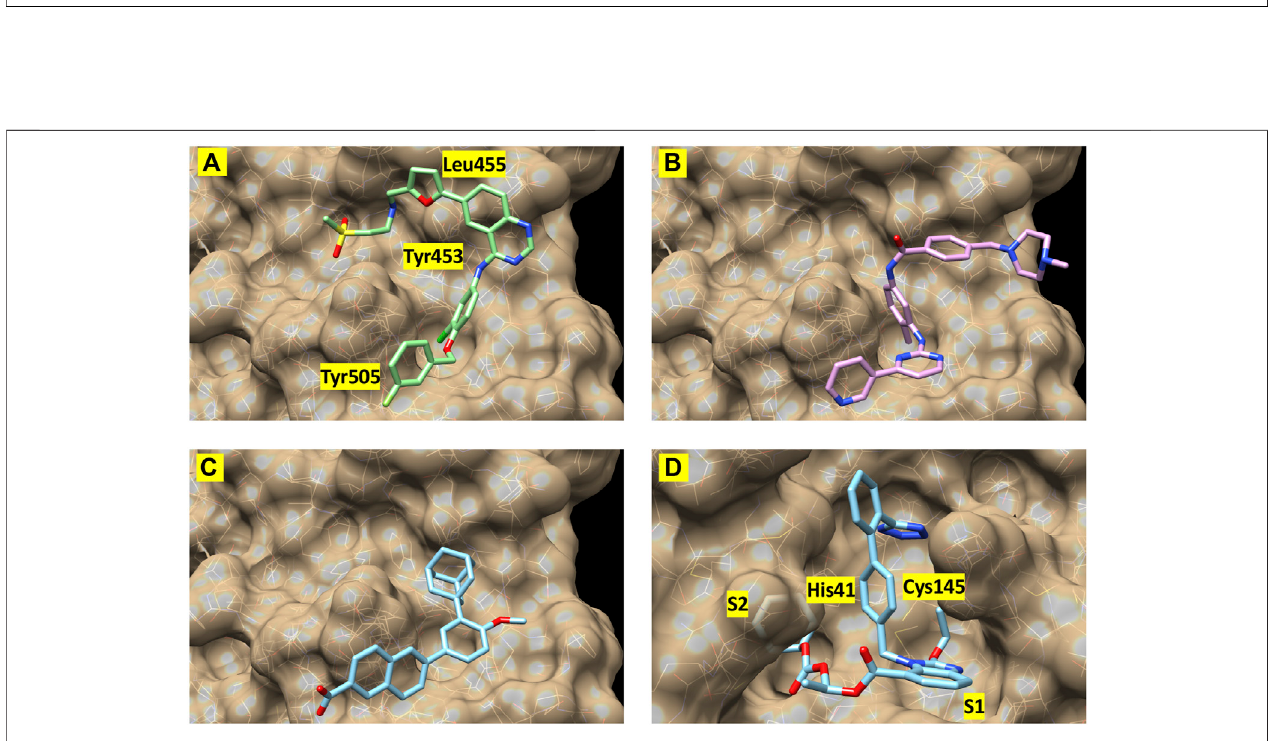
FIGURE7| Best-scoringposefromdockingfor (A) lapatinib, (B) imatinib,and (C) adapalenetothereceptorbindingdomainofthespikeprotein(spike1site).Panel (D) shows the best-scoring dock pose for candesartan cilexetil to M pro . Labels identify protein residues neighboring the docked compounds.